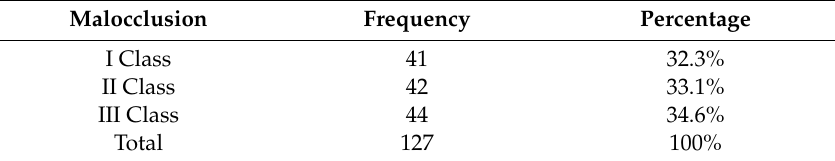
Table 2. Frequency and percentage of the sample divided according to the molar relationship.